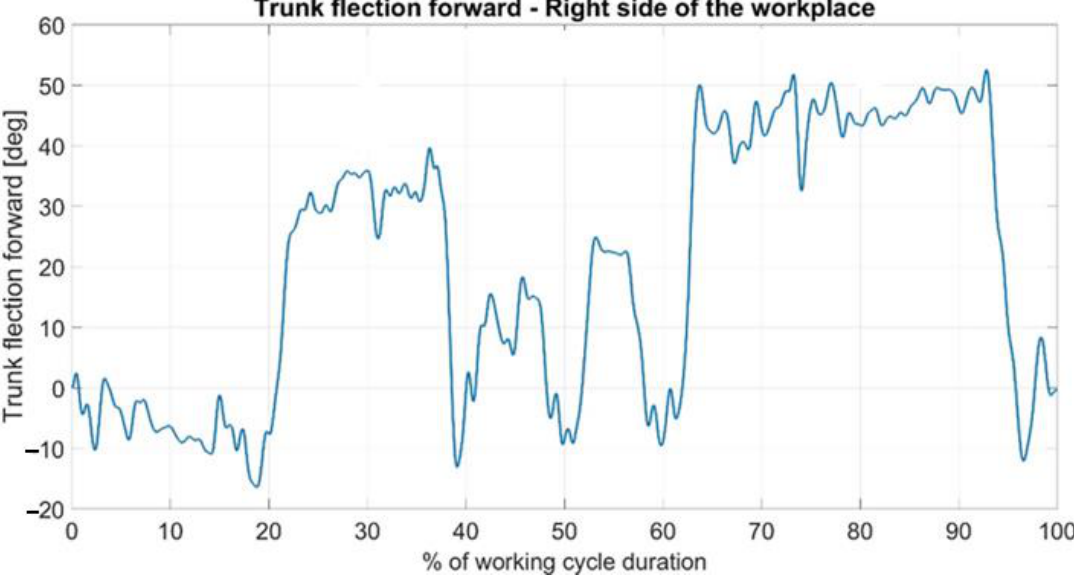
Figure 8. Kinematic signal of trunk flexion forward in one working cycle (right side of the workstation).